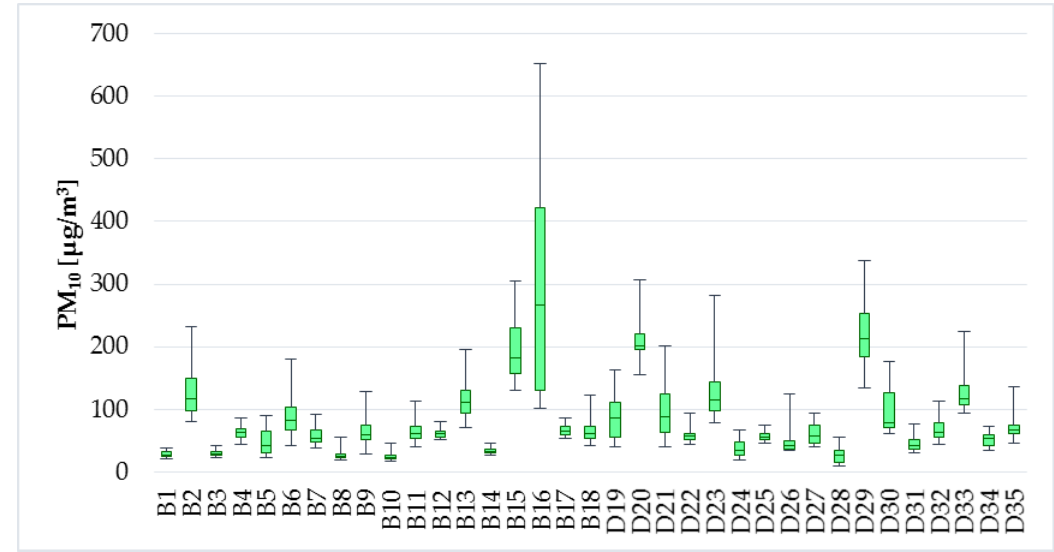
Figure 8. PM 10 concentrations.